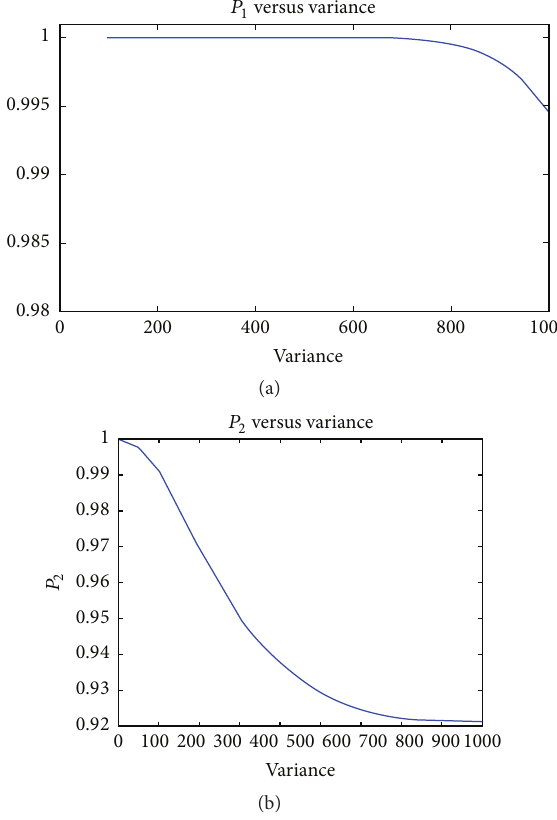
Figure 4: Changes of 𝑃 1 and 𝑃 2 against